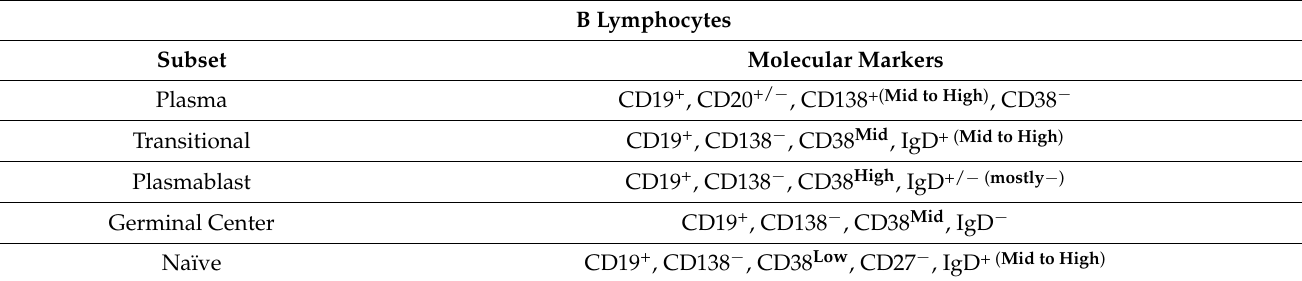
Table 1. Lineage definitions for lymphocyte subsets used in the